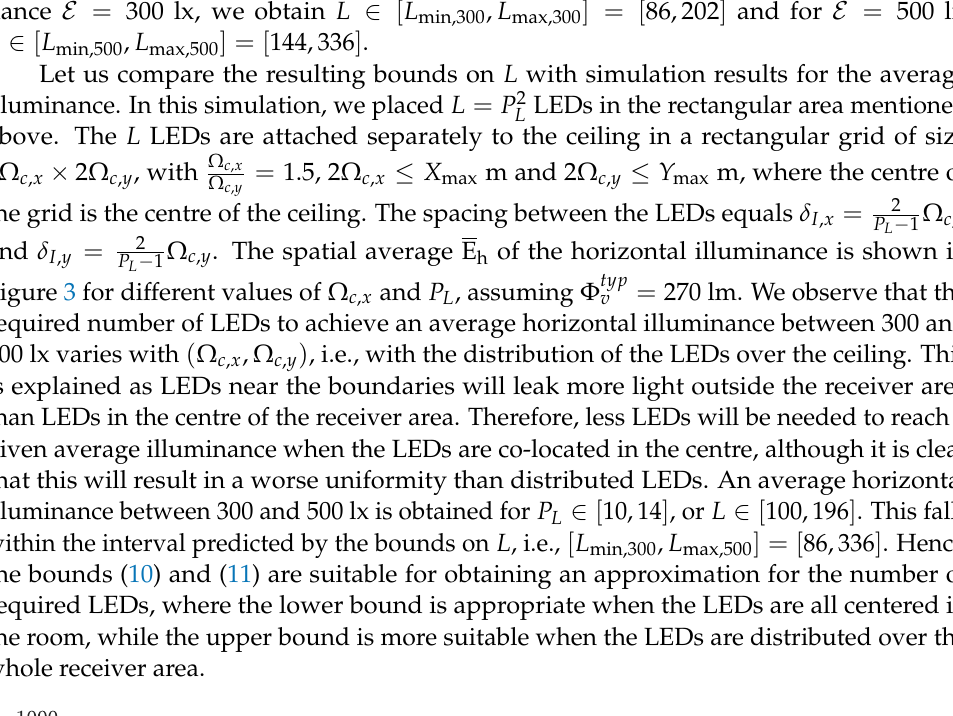
Figure 3 for different values of Ω c , x and P L , assuming Φ typ v